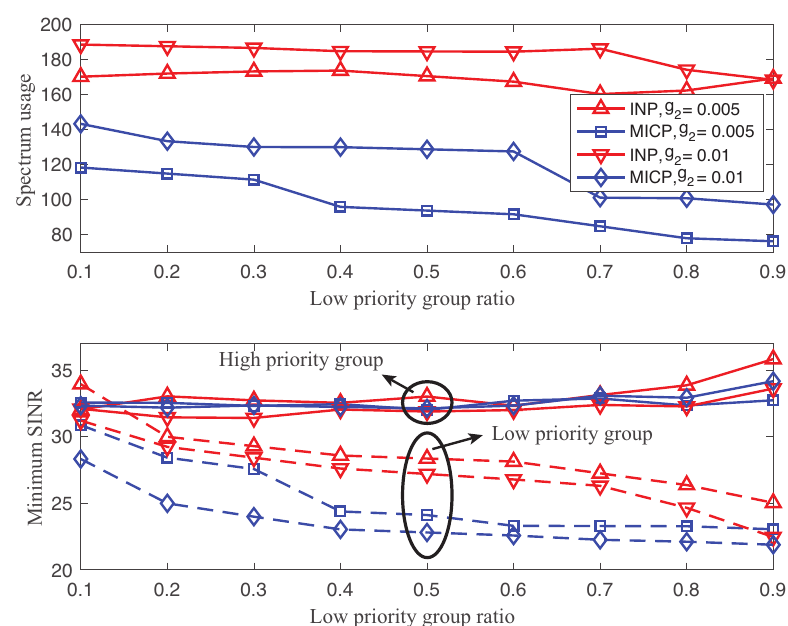
Figure 8. Expected values of spectrum usage ( top ) and minimum SINR ( bottom ) using the solutions of both the INP and MICP as functions of different low priority group ratios ( r = 0.1, . . . ,0.9) with θ = 30 ◦ , g 2 = 0.005,